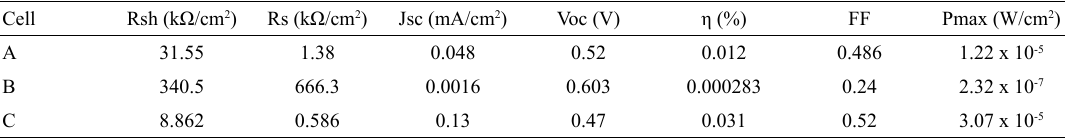
Table 2. Photovoltaic parameters for the ZnO based